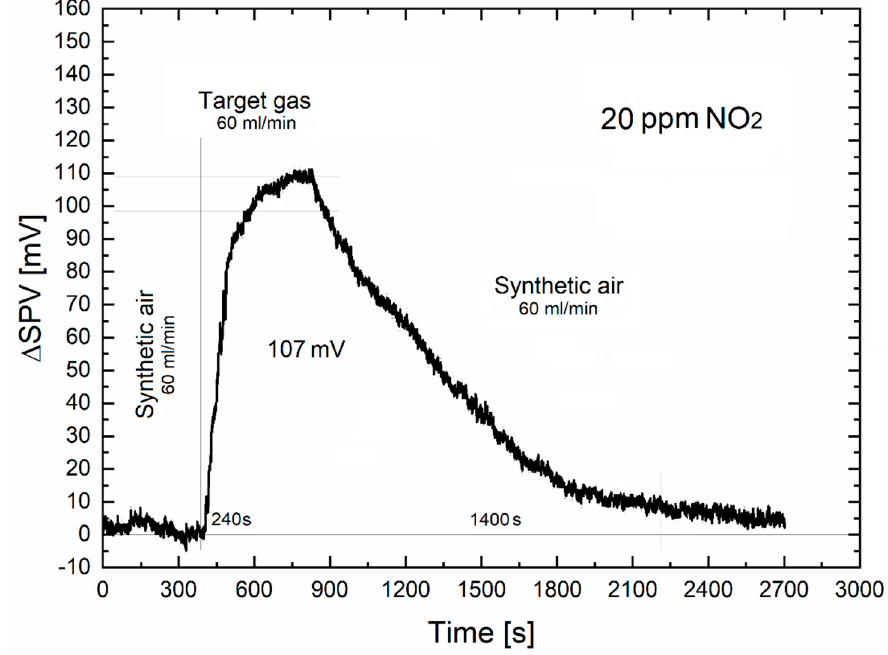
Figure 3. The time-dependent variation of SPV signal for a synthetic air flow rate of 60 mL / min and 20 Figure 3. The time ‐ dependent variation of SPV signal for a synthetic air flow rate of 60 mL/min and 20 ppm ppm of NO 2 of NO 2 concentration. Table 1. Variation in the SPV signal at various NO 2 gas flow rates at constant 20 ppm relative concentration, together with the basic dynamic parameters.